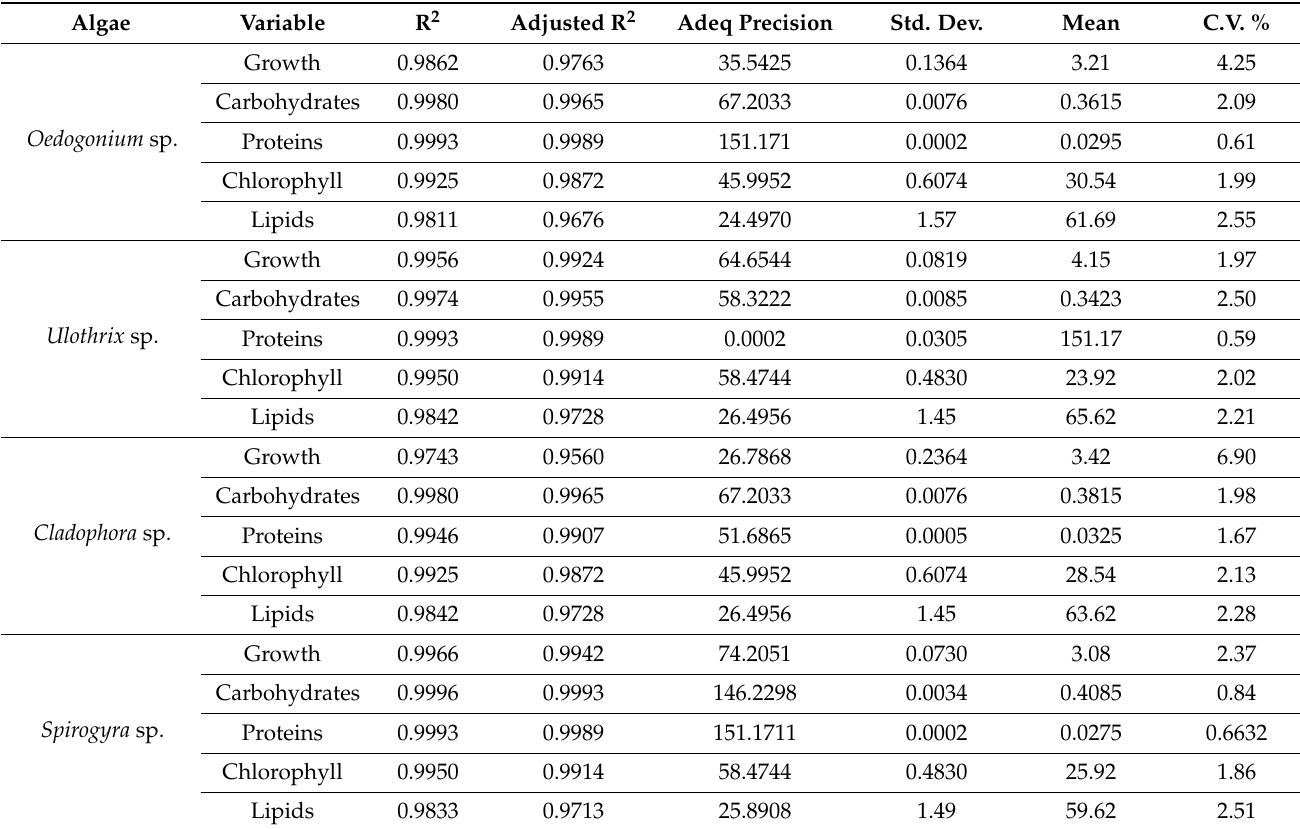
Table 3. Fit statistics of